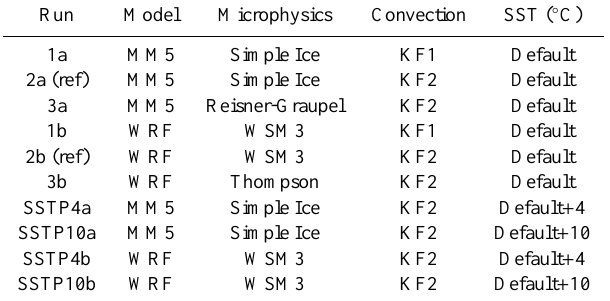
Table 1. Overview of the model